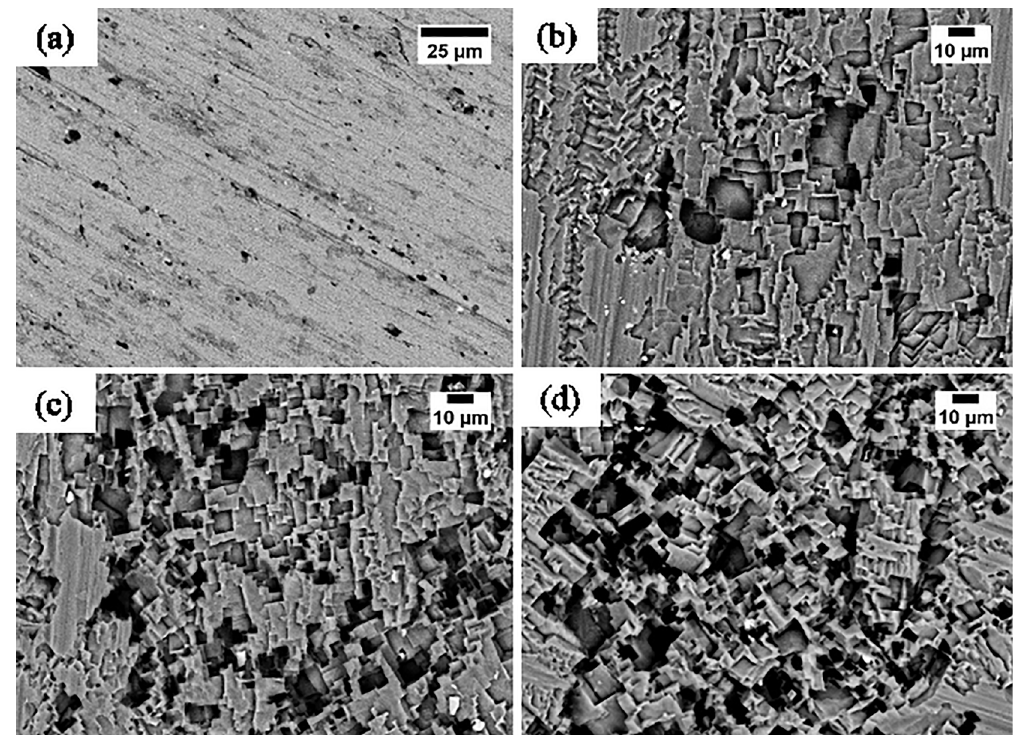
Figure 1. SEM of the surfaces of 5052 aluminum alloy: (a) after being sanded with # 320, #600 and #1200 grit, sandpapers, successively; (b), (c) and (d) after etching in HCl (2M ) after 10, 20 and 30 min, respectively.